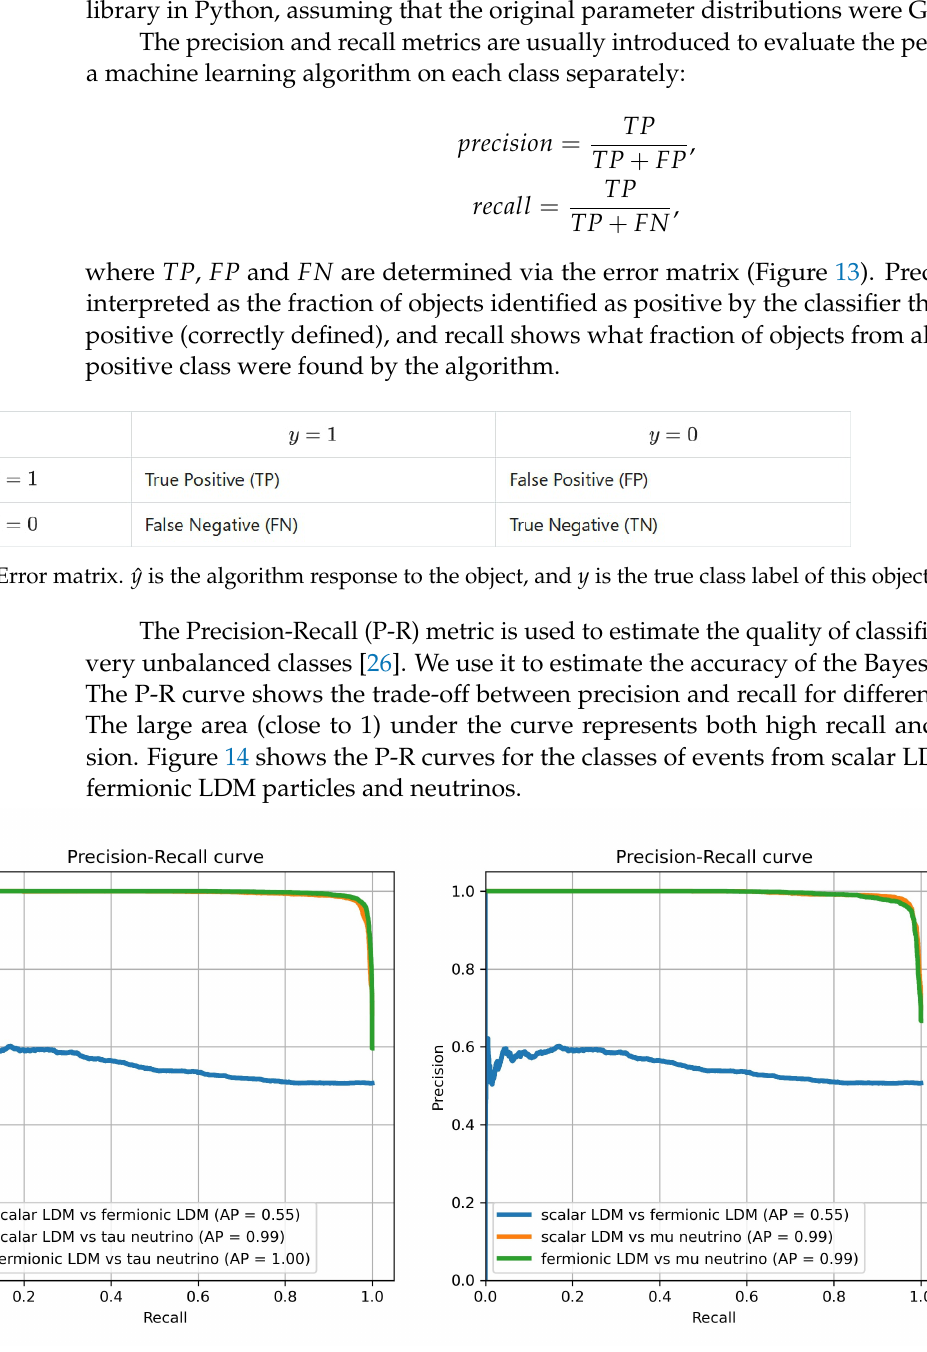
Figure 14. Precision-Recall curves for fermionic and scalar LDM, ν τ and ν µ events. The higher the area under the curve, the more accurately the event is